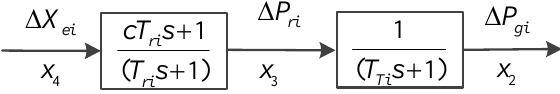
Figure 5. Transfer function of reheat steam turbine in the i th control area.